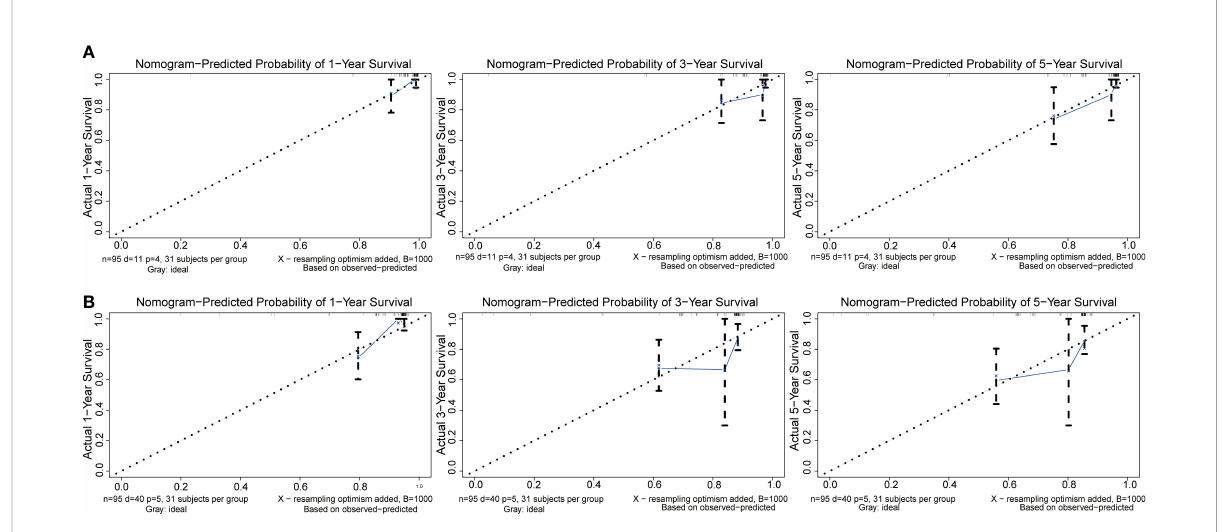
FIGURE 8 The calibration curves of the nomogram predicting 1-year, 3-year, and 5-year (A) CSS and (B) OS in the training